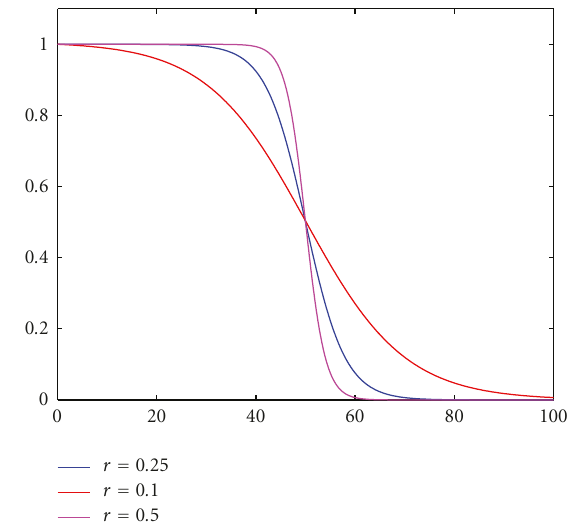
Figure 4: This figure shows three plots of φ ( a ) for a ∈ [0,100]. In this example e t = 50. As r increases the drop in energy about e t becomes the more